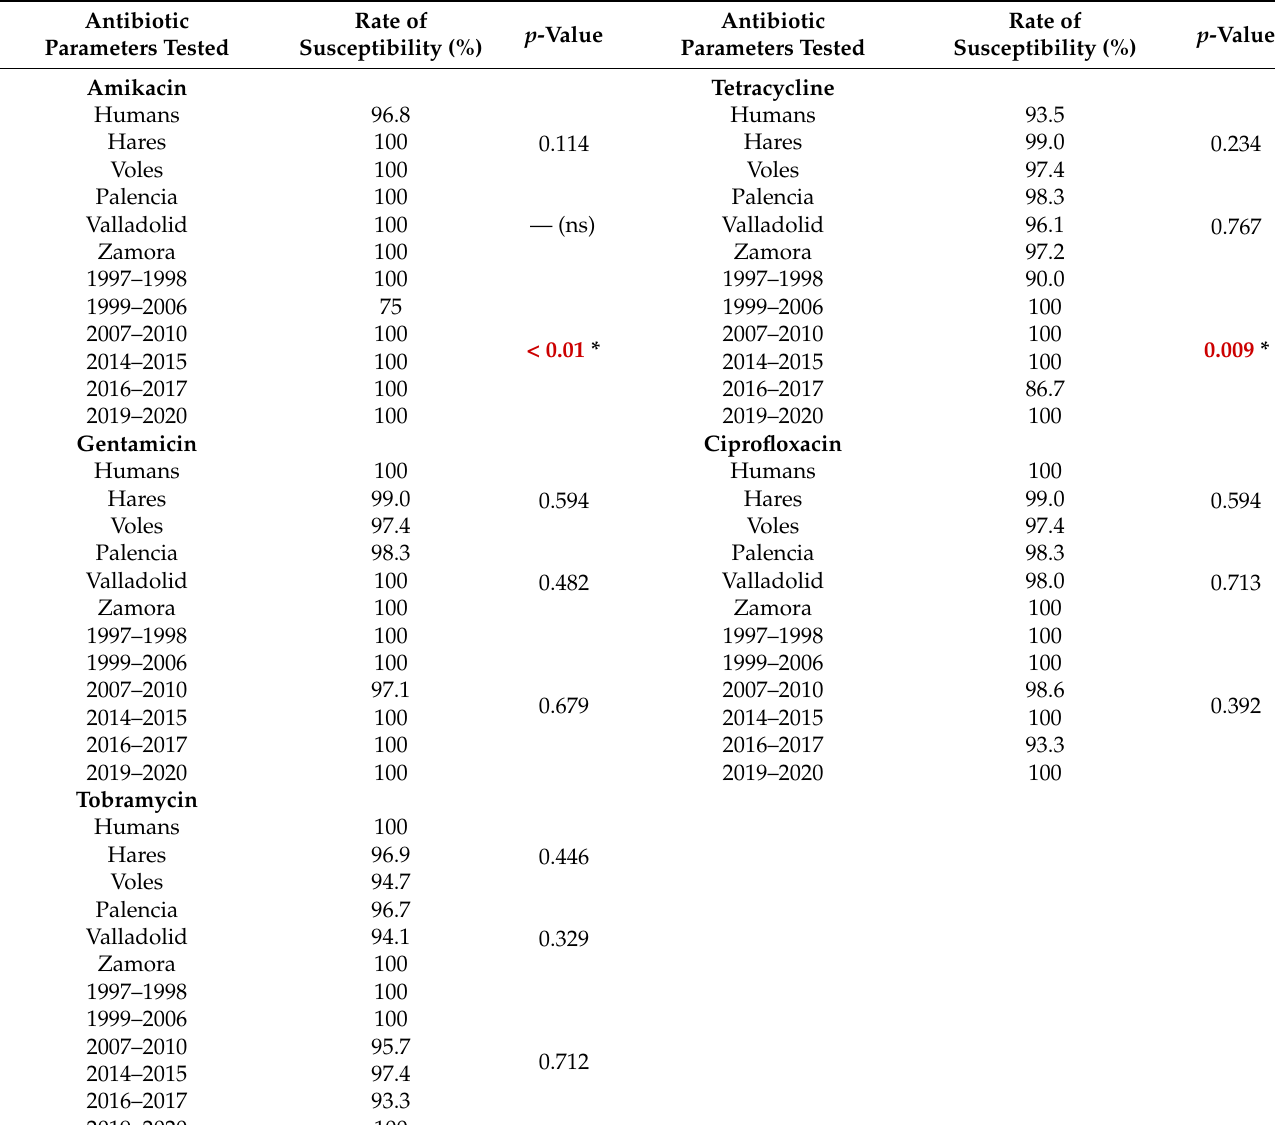
Table 3. Results of p -values obtained from statistical analysis of five antibiotics showing highest susceptibility percentages and variables “isolation source”, “Castilla y Le ó n provinces”, and “time frames” (set up according to the number of isolates existing each